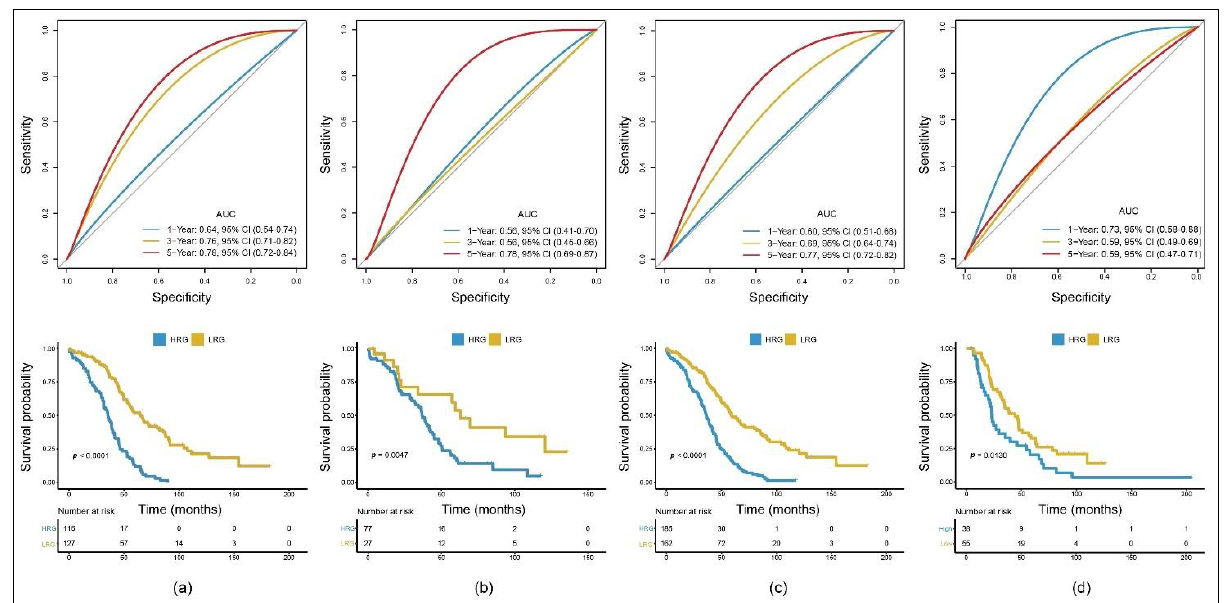
Figure 2. Construction and validation of the TME-related 11-gene risk score (RS) for serous ovarian cancer (SOC) with 1-, 3- and 5-year receiver operating characteristic (ROC) and OS Kaplan – Meier (KM) curves within the different cohorts: ( a ) TCGA training cohort; ( b ) TCGA testing cohort; ( c ) entire TCGA cohort; ( d ) Australian ICGC cohort.